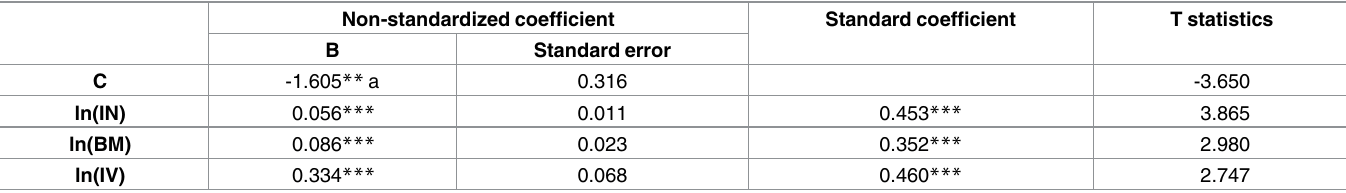
Table 5. Results from the STIRPAT model for sample A.